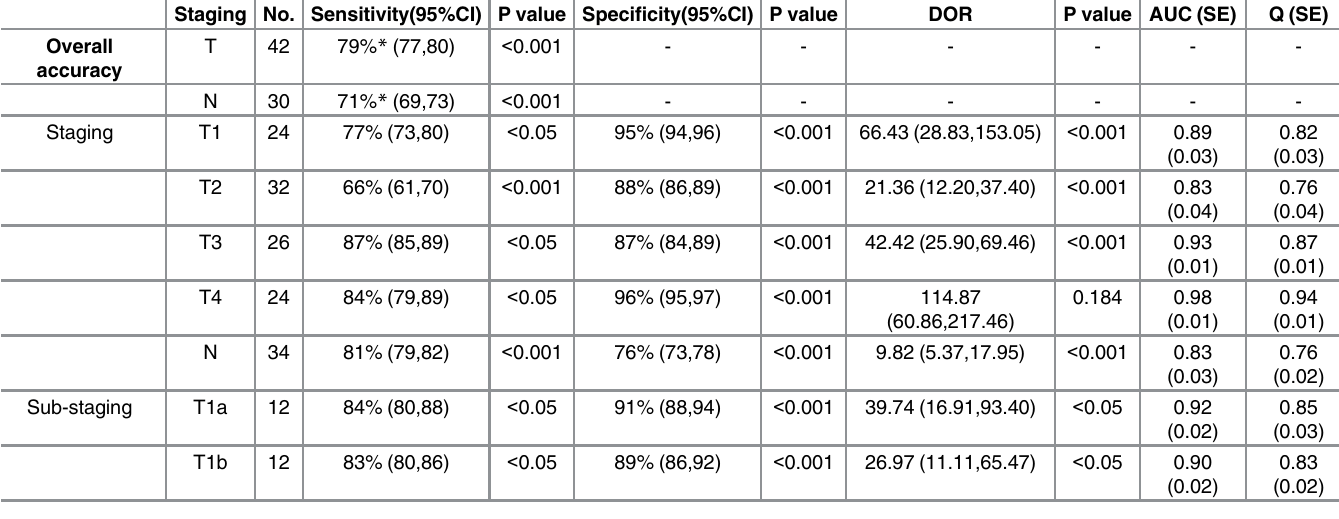
Table 2. Diagnostic accuracy of EUS in T/N staging for